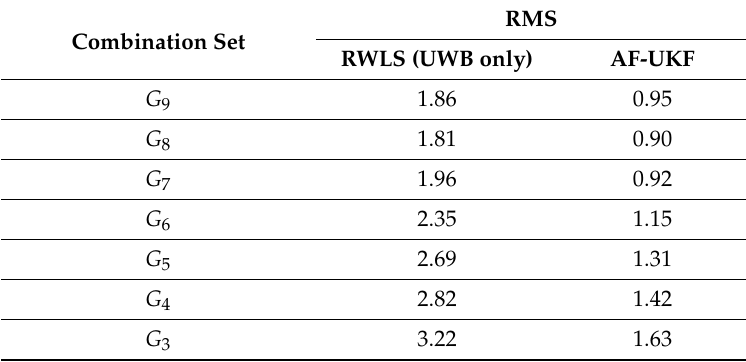
Table 6. The minimum RMS errors from G 3 to G 9